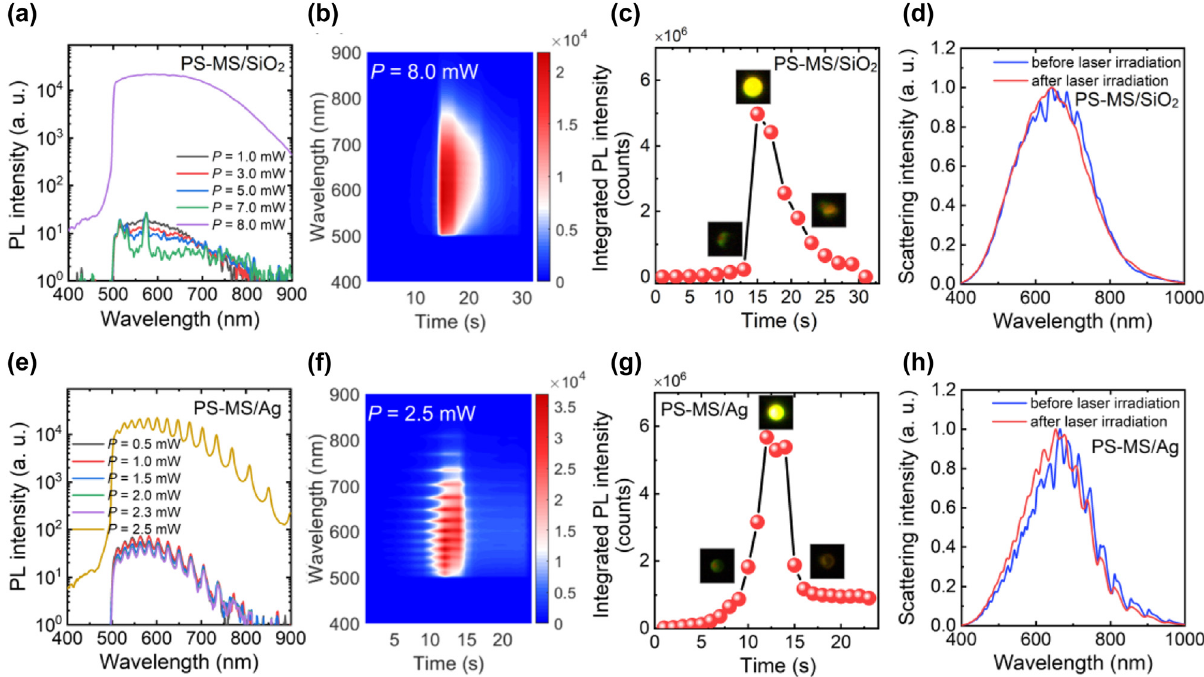
and a PS-MS/Ag microcavity. (a) PL spectra Figure 2: Dramatic increase in PL intensity induced by laser irradiation in a PS-MS/SiO 2 microcavity at different laser powers. (b) Evolution of the PL spectrum with increasing irradiation time measured measured for a PS-MS/SiO 2 microcavity excited by using 488-nm laser light at 8 mW. (c) Dependence of the integrated PL intensity of the for the PS-MS/SiO 2 on the irradiation time. The images of the PS-MS/SiO microcavity recorded by using a CCD at different irradiation times are PS-MS/SiO 2 2 microcavity before (blue curve) and after (red curve) laser shown in the insets. (d) Scattering spectra measured for the PS-MS/SiO 2 irradiation. (e) PL spectra measured for a PS-MS/Ag microcavity at different laser powers. (f) Evolution of the PL spectrum with increasing irradiation time measured for the PS-MS/Ag microcavity excited by using 488-nm laser light at 2.5 mW. (g) Dependence of the integrated PL intensity of the PS-MS/Ag microcavity on the irradiation time. The images of the PS-MS/Ag microcavity recorded by using a CCD at different irradiation times are shown in the insets. (h) Scattering spectra measured for the PS-MS/Ag microcavity before (blue curve) and after (red curve) laser